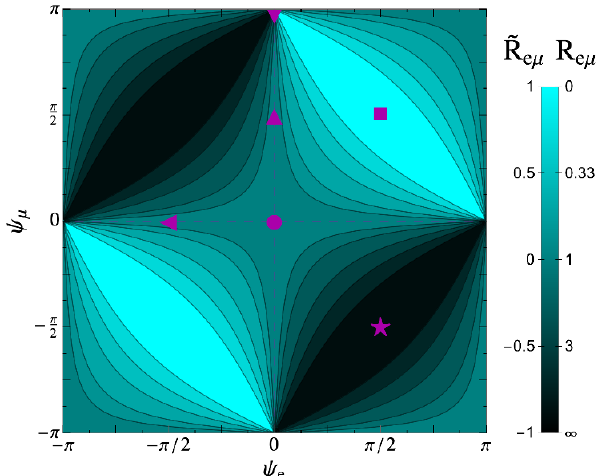
Figure 3 . Ratios R e(cid:22) and e R e(cid:22) as de(cid:12)ned in eqs. (2.9), (2.10) of the LNV and LNC processes K ! (cid:25)e(cid:22) . The coloured isosurfaces on the e (cid:0) (cid:22) plane denote regimes for R e(cid:22) and e R e(cid:22) . Symbols as in (cid:12)gure